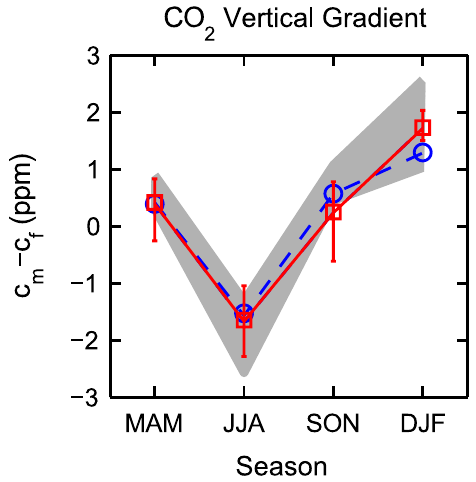
Fig. 4. Seasonally averaged vertical CO 2 gradients ( c m − c f ) pre- dicted by SBLM with synthetic CT-TM5 forcing (dashed blue, corresponding to dashed blue lines in Fig. 3), and the original vertical CO 2 gradient from the CT-TM5 data assimilation system (red). Gray shading indicates the range of solutions for a range of sub-grid-scale boundary layer entrainment (as in Fig. 3); gradients monotonically decrease in magnitude with stronger entrainment. Error bars indicate the maxima and minima of seasonally averaged gradients for the 8yr